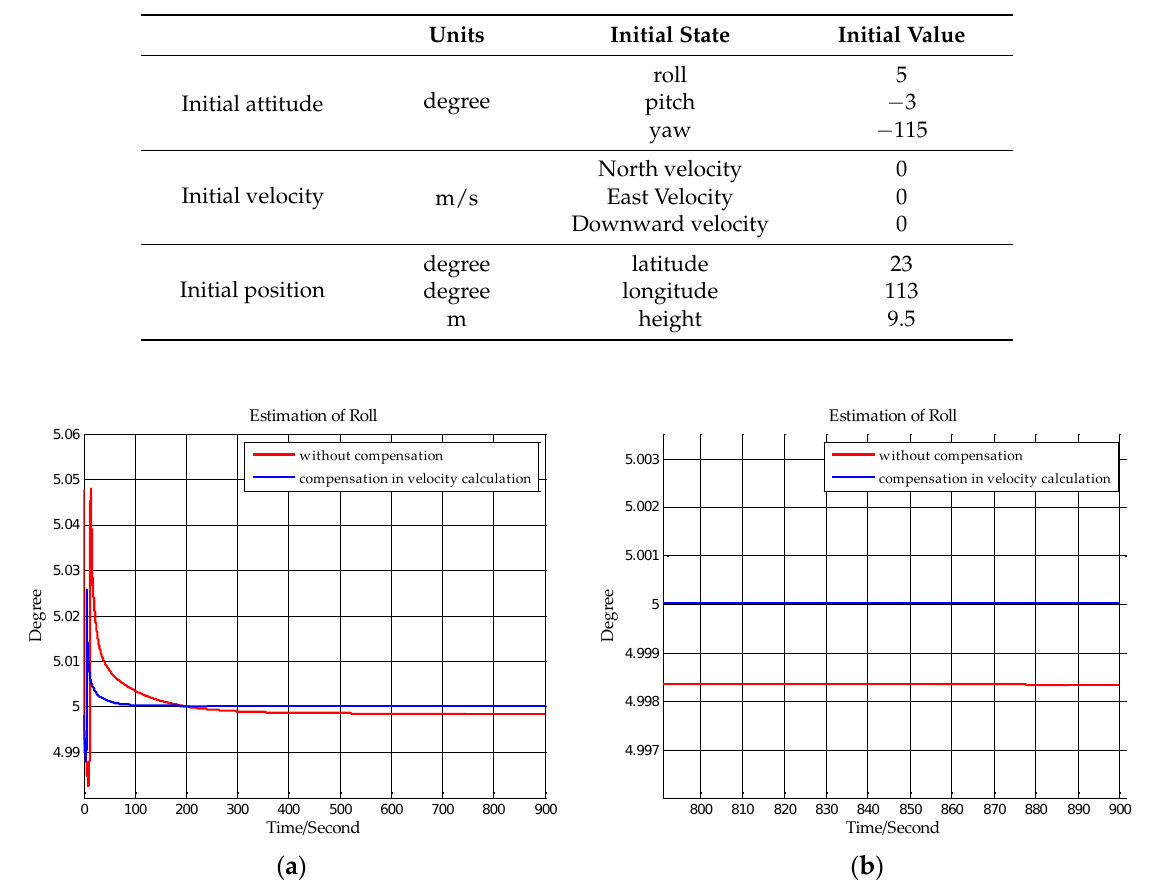
Table 3. Initial states of the INS.